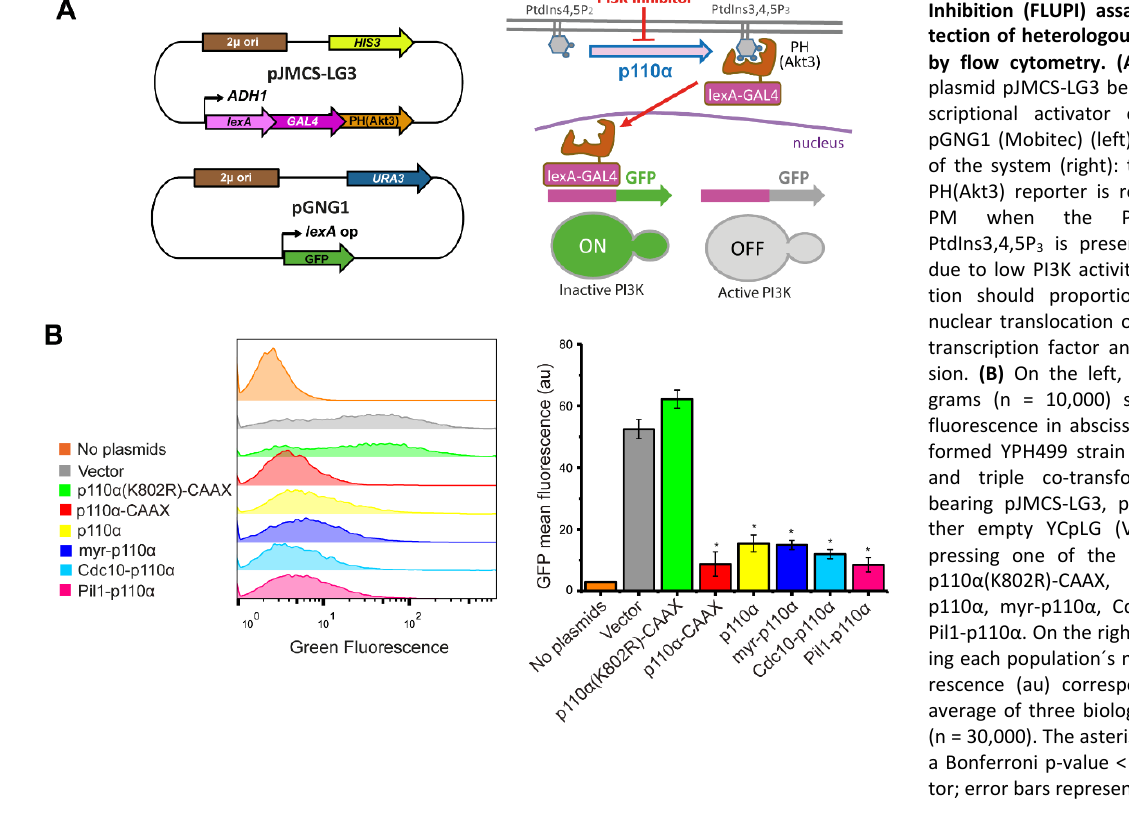
FIGURE 4: The FLUorescence by PI3K Inhibition (FLUPI) assay for the de- tection of heterologous PI3K activity by flow cytometry. (A) Sketches of plasmid pJMCS-LG3 bearing the tran- scriptional activator construct and pGNG1 (Mobitec) (left) and rationale of the system (right): the LexA-Gal4-